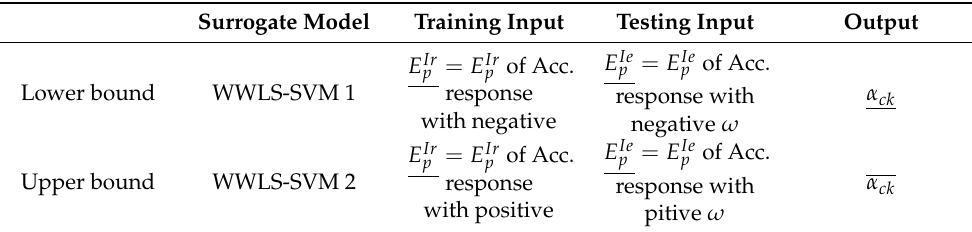
Table 1. Input and output variables for training and testing of